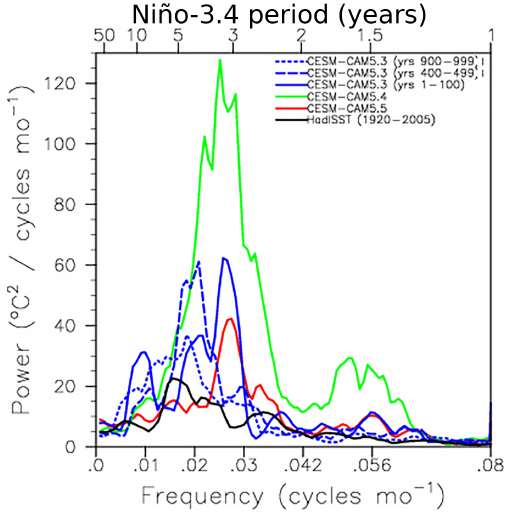
Figure 12. Niño-3.4 power spectra for HadISST observations (black curve), CESM-CAM5.3 (blue curve), CESM-CAM5.4 (green curve), and CESM-CAM5.5 (red curve). Years 100–199 are displayed for CESM-CAM5.5 while the power spectra for CESM- CAM5.4 represent the entire simulation. For CESM-CAM5.3, the spectra are displayed for various 100-year samples of the run, as denoted by the legend. Note the range of scale on the y axis varies between panels.